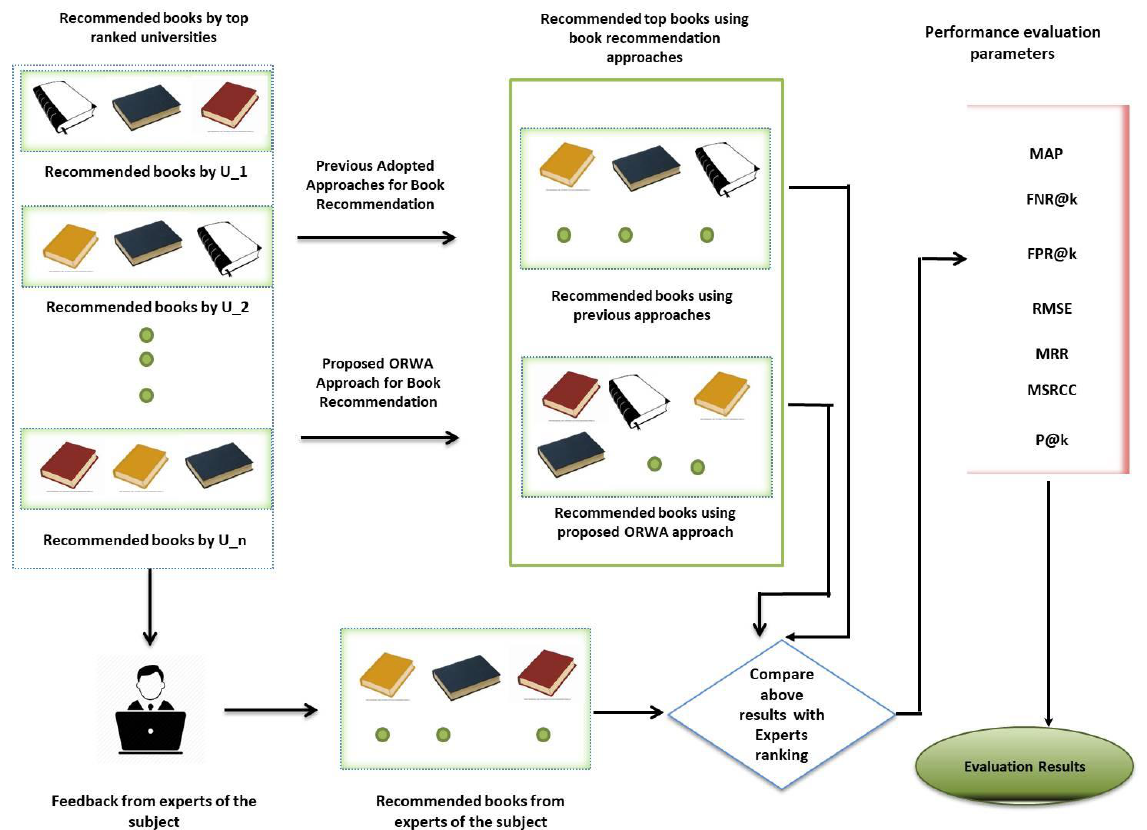
Figure 4. Performance evaluation scheme for the book recommendation approach.